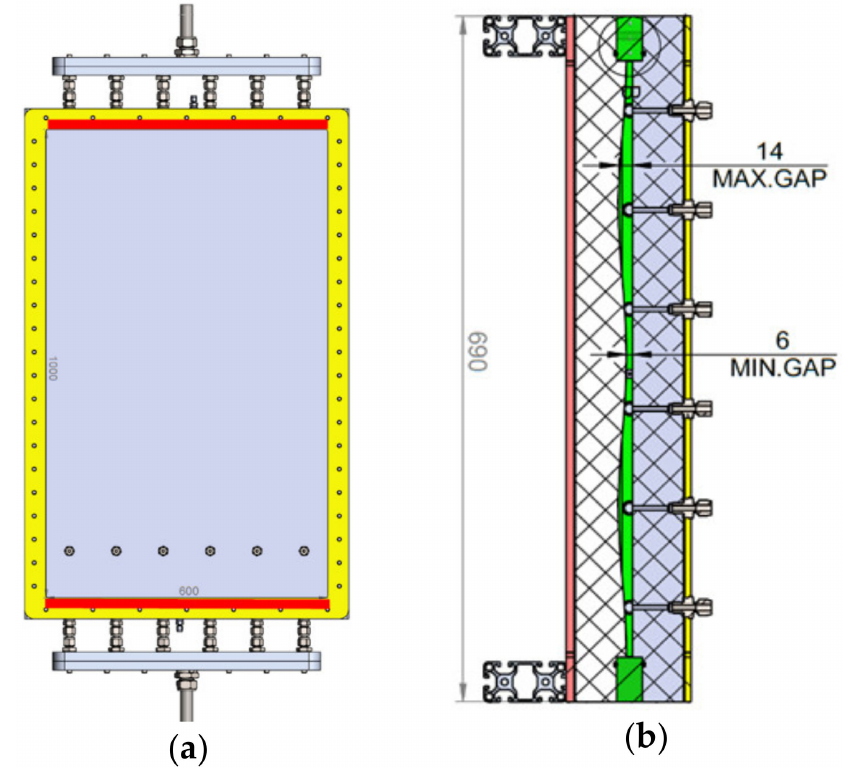
Figure 2. Drawing of eccentric Hele–Shaw cell. ( a ) Top view; ( b ) cross-section view. The experimental setup consists of two centrifugal pumps for pumping displacing and displaced fluids into the cell, a variable frequency drive to adjust the displacing fluid flow rate, a Heinrichs magnetic flow meter, two GE Druck pressure transmitters, and a Fuji differential pressure transmitter. The ports of the pressure transmitters were placed in spaces with a depth of 15 mm, length of 600 mm, and width of 15 mm (more than 10 mm average gap in the main body of the cell), as shown by the color red in Figure